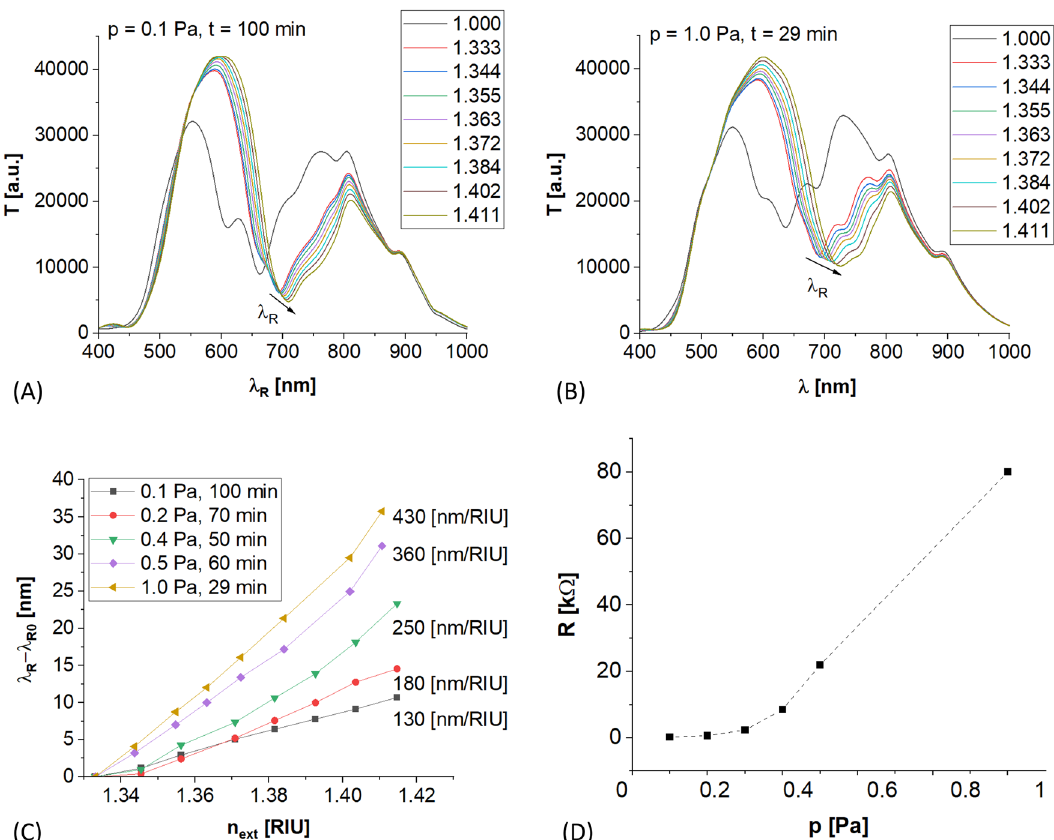
Figure 5: Evolution of ITO-LMR sample properties with p . Examples of similar LMR spectral patterns in response to n ext varying from 1 up to 1.42 RIUreceivedatdifferentITOdeposition p and t areshownin(A) and(B).In(C)isshownrelativeshiftofthe λ R with n ext forselectedsetsof p and t . The λ R0 is the λ R at n ext = 1.3330 RIU for each set of p and t . In (D) is shown relation between resistance ( R ) of 25-mm-long active part of ITO-LMR structure and the p